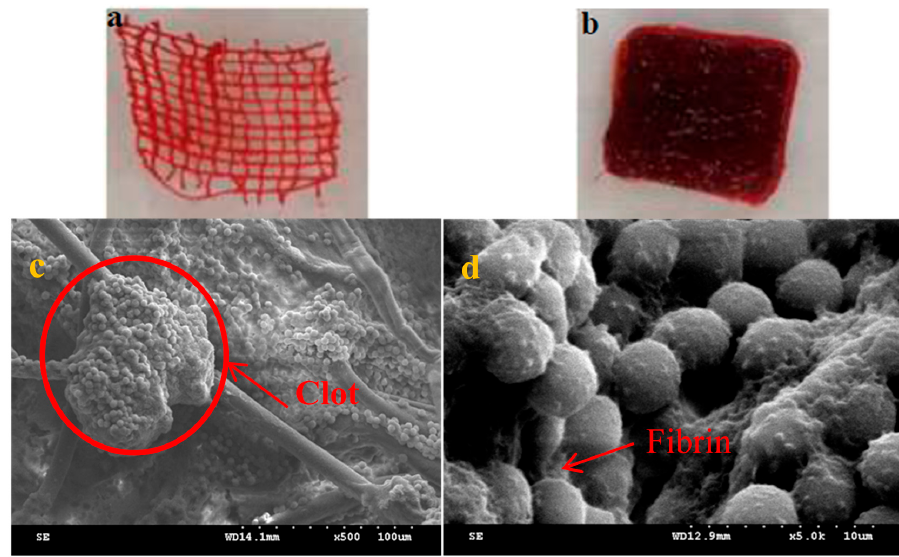
Figure 7. ( a ) Cotton cloth after blood absorption; ( b ) TCP nonwoven after blood absorption. SEM observation of TCP nonwoven after blood absorption ( c : 500×; d : 5000×).